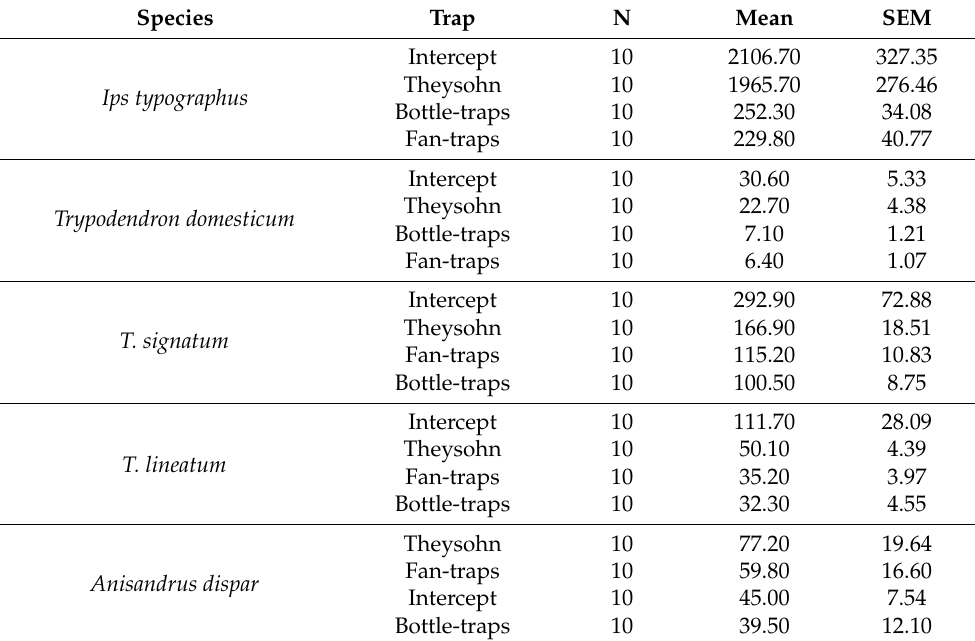
Table 1. Total catches per trap across the whole trapping period for each of the two groups of Scolytinae (the “xylomycetophagous” species, i.e., Trypodendron lineatum , T. domesticum , T. signatum and Ips typographus ). For each species, the traps are listed in decreasing order according to trapping results. Species Trap